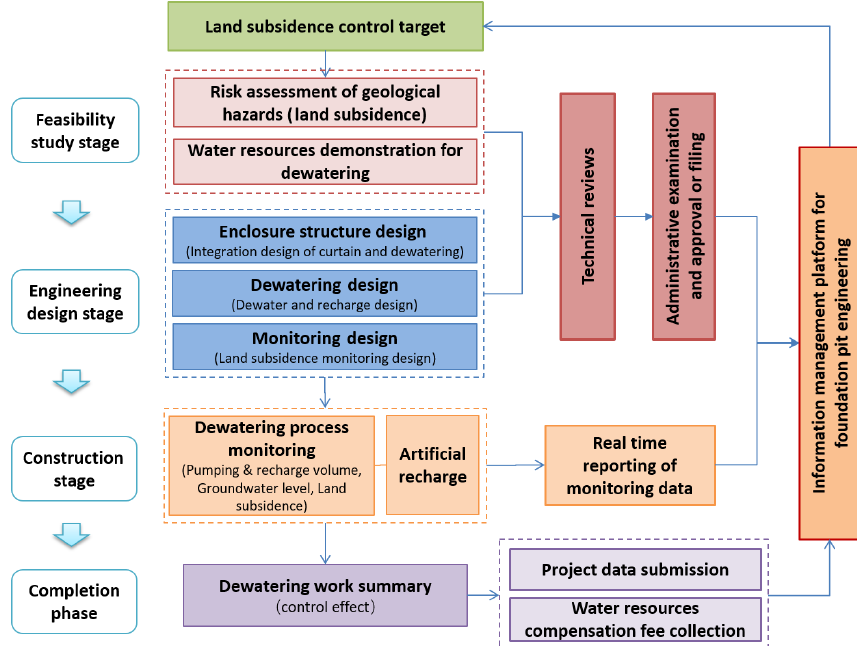
Figure 3. Key workflow of whole process management of deep foundation pit dewatering based on land subsidence control.